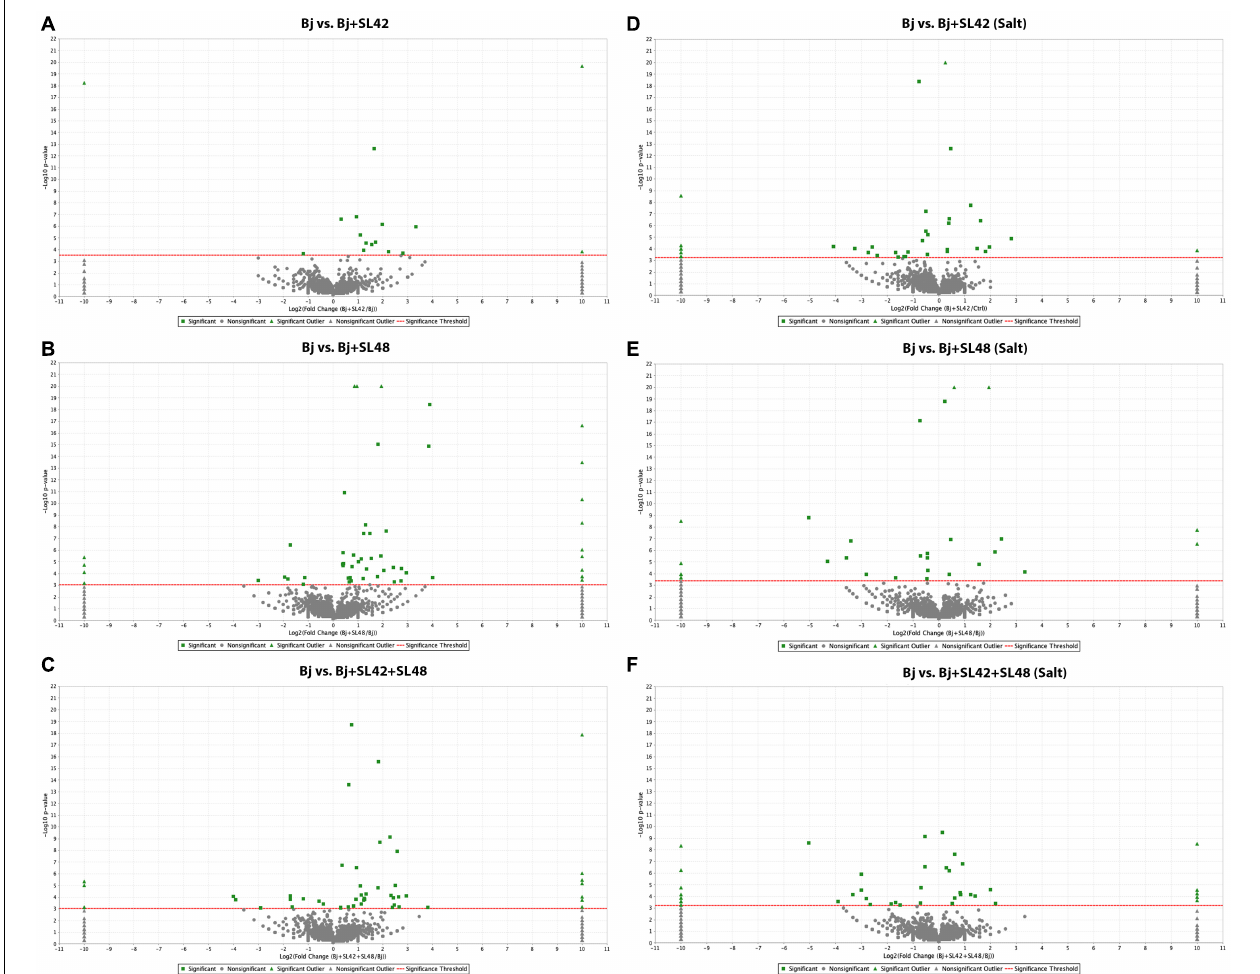
FIGURE 3 | Volcano plots of quantitative spectra comparison between Bradyrhizobium japonicum (control) and bacterial co-inoculated treatments under optimal and salt-stressed conditions. (A) Bj vs. SL42 (B) Bj vs. SL48 (C) Bj vs. SL42 + SL48 (D) Bj vs. SL42 (salt) (E) Bj vs. SL48 (salt) (F) Bj vs. SL42 + SL48 (salt). Fold change by category, reference control treatment is plotted on X-axis and Fisher’s exact test (Benjamini-Hochberg correction) is plotted on